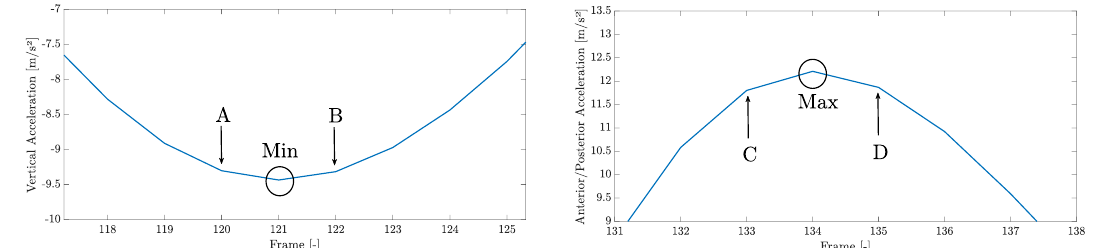
Figure 6. Acceleration data. Left, vertical accelerations close to the bottom point of the cycle; right, anteroposterior accelerations close to the maximum point of the cycle. On the abscissa axis, the time evaluated as the number of samples captured.